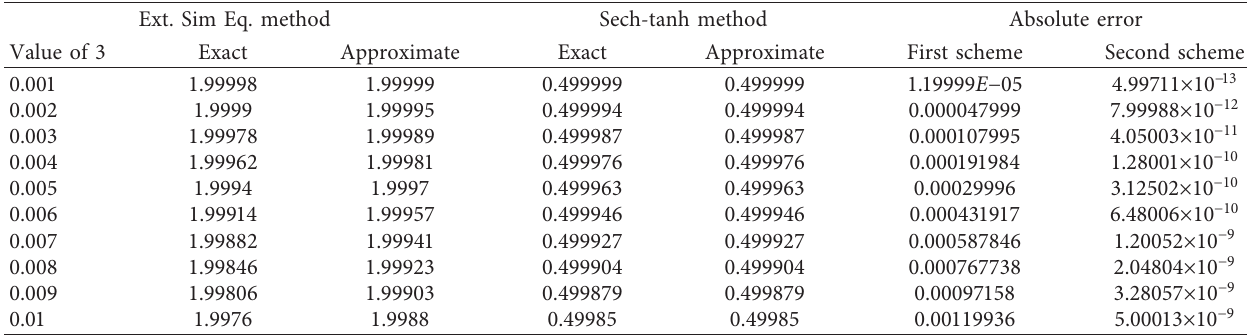
Table 1: Exact, semianalytical, and absolute values of error with different values of Z with respect to the obtained solution via extended simplest equation method (18) and sech-tanh method (31) via the Adomian decomposition